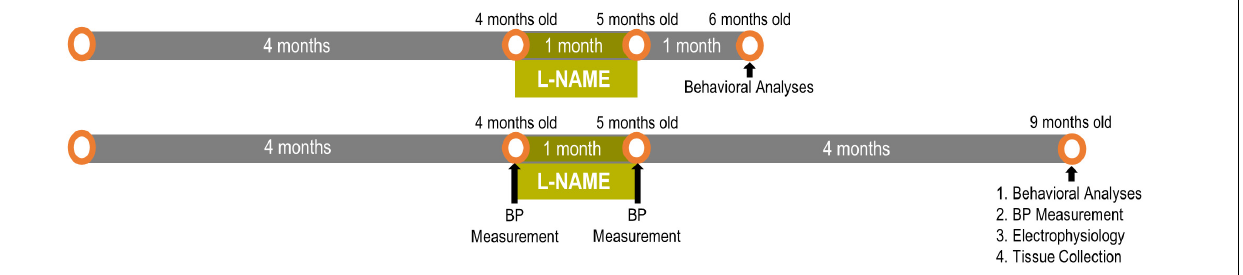
Frontiers in Neuroscience |